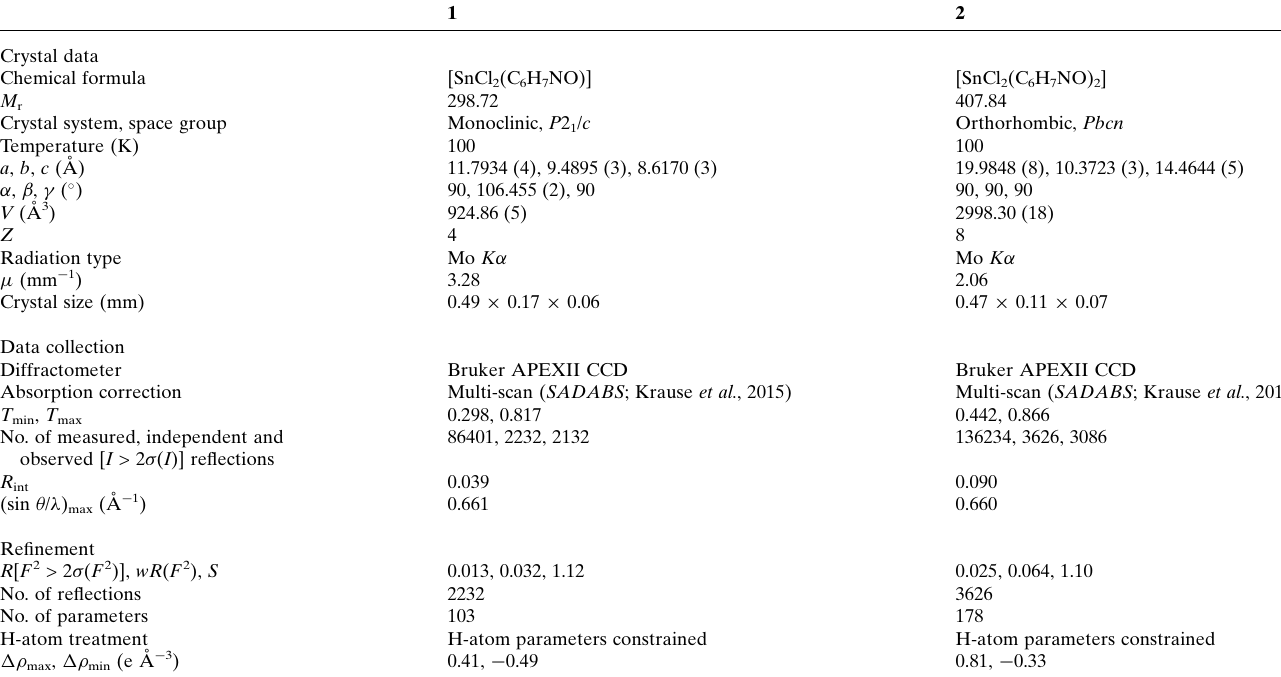
Crystal data Chemical formula